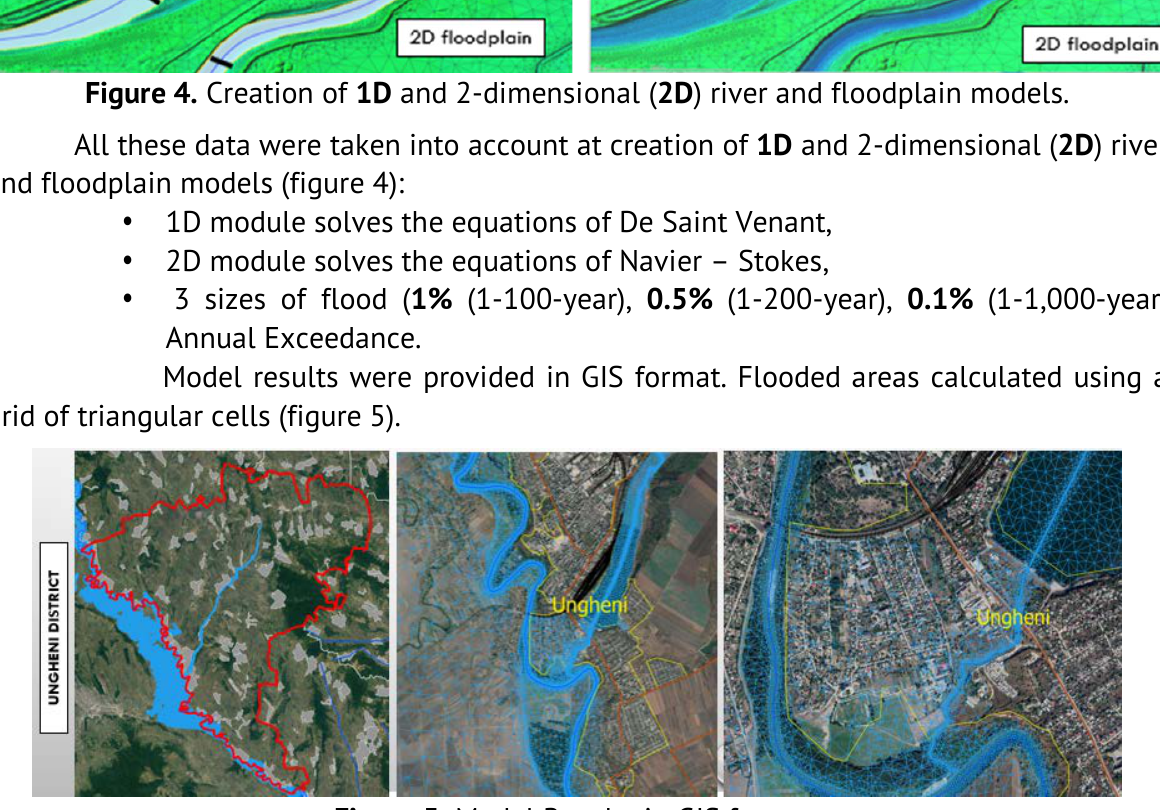
Figure 5. M odel Results in GIS